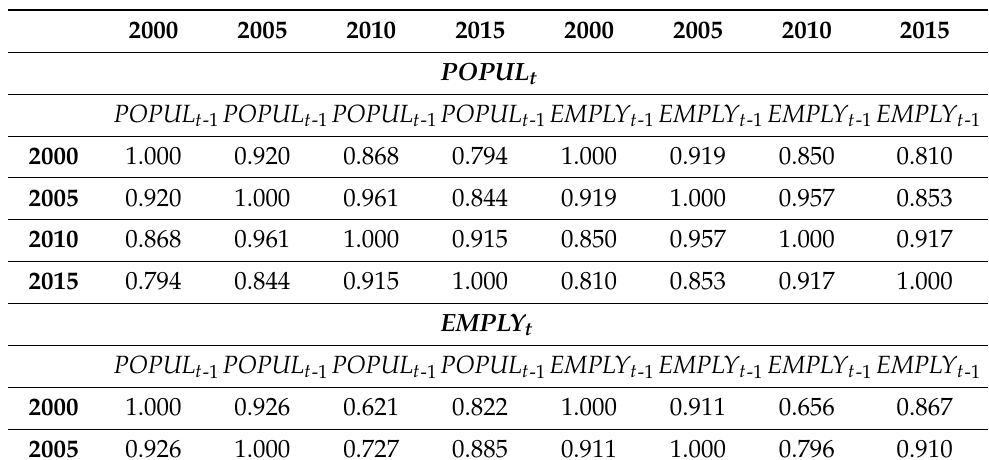
Table 3. Correlations across the GWR Estimates of Current Population and Current